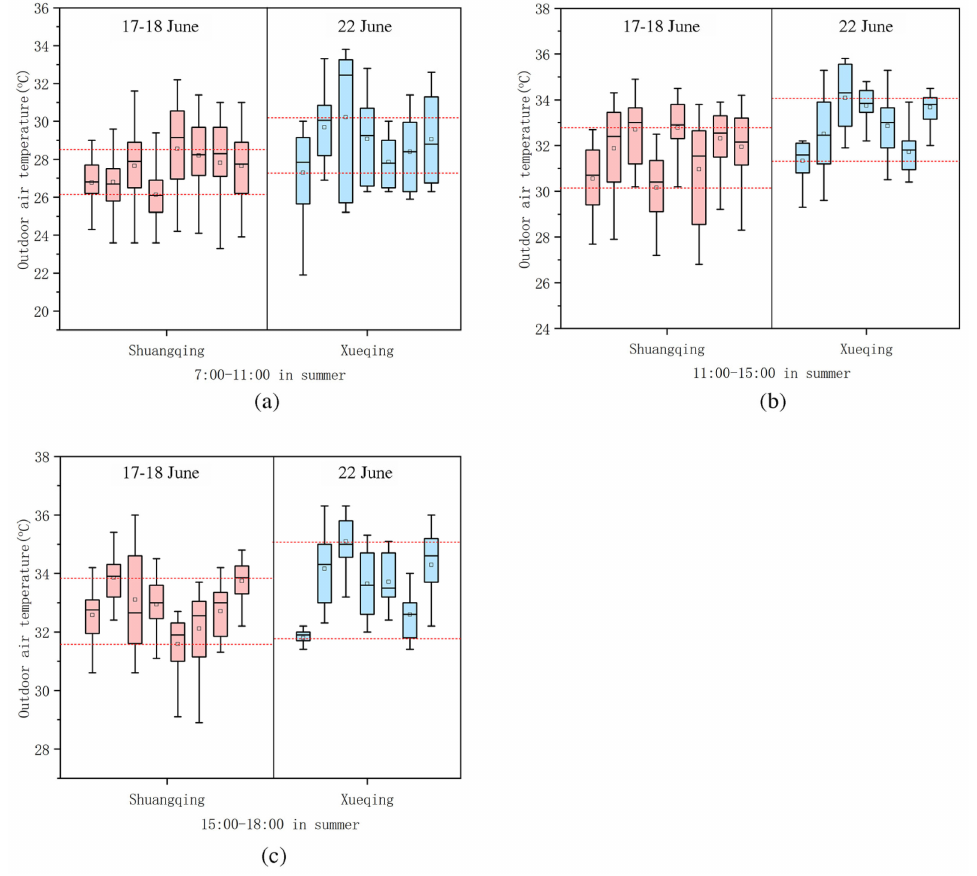
Figure 9. Air temperature of observation points at 7:00–11:00 ( a ), 11:00–15:00 ( b ), 15:00–18:00 ( c ) in the two residential